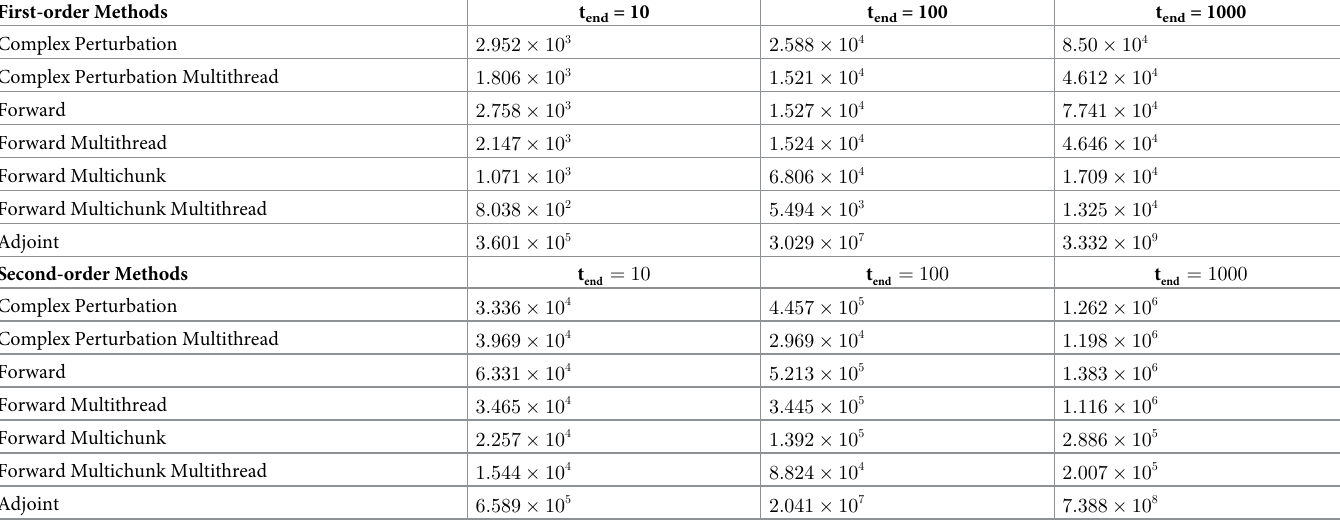
Tables 6 and 7 compare the computational speeds of the different methods for the stochastic SIR and branching process models. As expected for the stochastic SIR model, computational speed varies roughly quadratically with the number N of individuals in the system. In the sto- chastic SIR model, the complex perturbation method proves to be twice as fast as the manual differentiation of (Eq 10) and (Eq 8) because the latter requires a larger number of individual computations. For the branching process model however, this trend reverses since manual Table 5. Computational time ( μ s) for the MCC ODE model. Parameters match those previously introduced in this manuscript. Multithread refers to parallelism across parameters. Multichunk refers to parallelism across compartments. We invoke the Julia solver AutoVern9(Rodas5(autodiff = false)) with a tolerance of 1 × 10 − 5 , reflecting the convergence tolerance. For the second-order adjoint method, the ForwardDiffOverAdjoint(QuadratureAdjoint(autodiff = false) solver option was